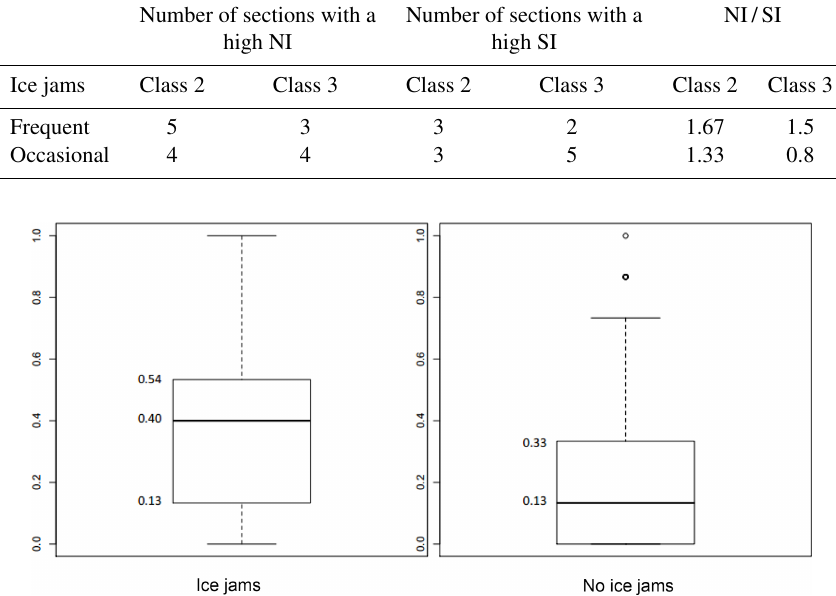
Table 2. Comparison of river sections with reported ice jam events (frequent and occasional occurrences) with the narrowing and sinuosity indices at these locations. NI/SI is the ratio of the narrowing index (NI) on the sinuosity index (SI). Number of sections with a